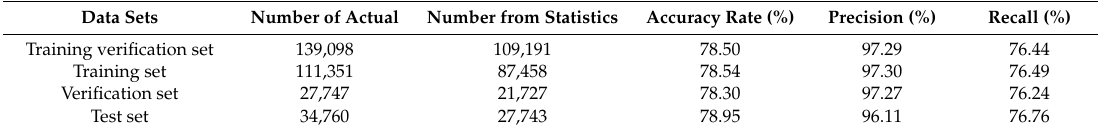
Table 2. YOLO-UA general model tra ffi c